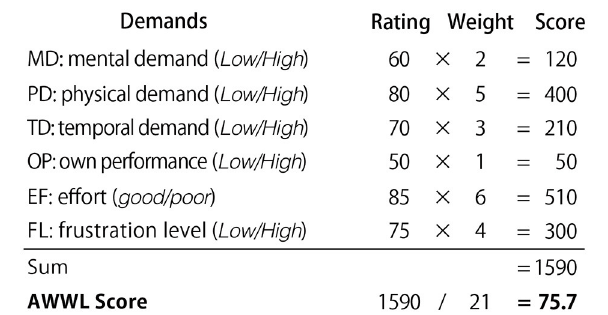
FIGURE 7 | Calculation example of AWWL. Participants scored each of the six NASA-TLX indices on a scale of 0 to 100 using the VAS. These scores were weighted in descending order and divided by 21 to obtain the average. The resulting mental workload would be a value between 0 and 100, with larger values indicating a larger mental